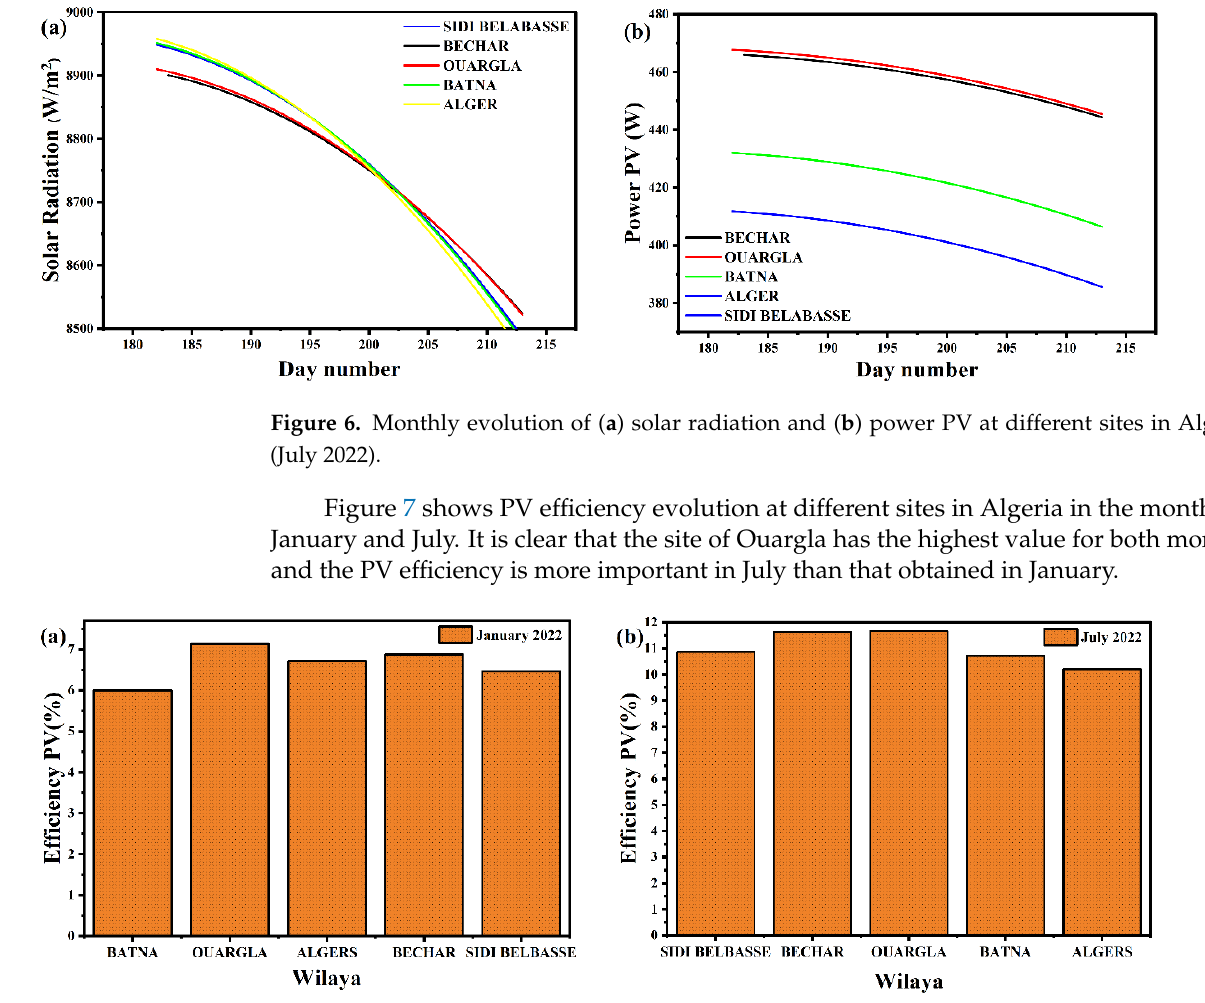
Figure 7. Monthly PV efficiency at different sites in Algeria in ( a ) January 2022 and ( b ) July 2022.